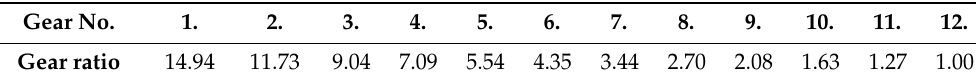
Table A1. Transmission gear ratios